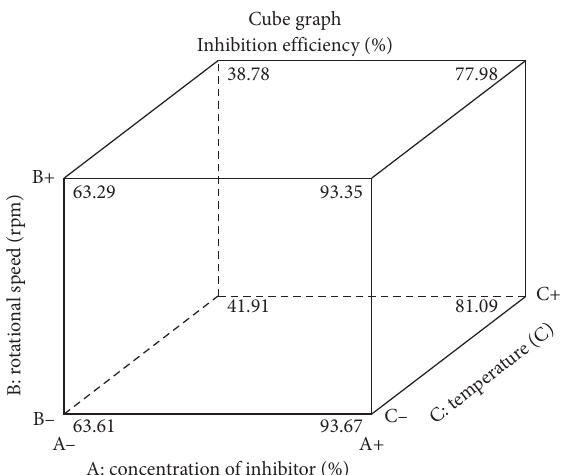
Figure 20: 3D plot of inhibition efficiency as a function of inhibitor concentration, rotation speed, and temperature variables.